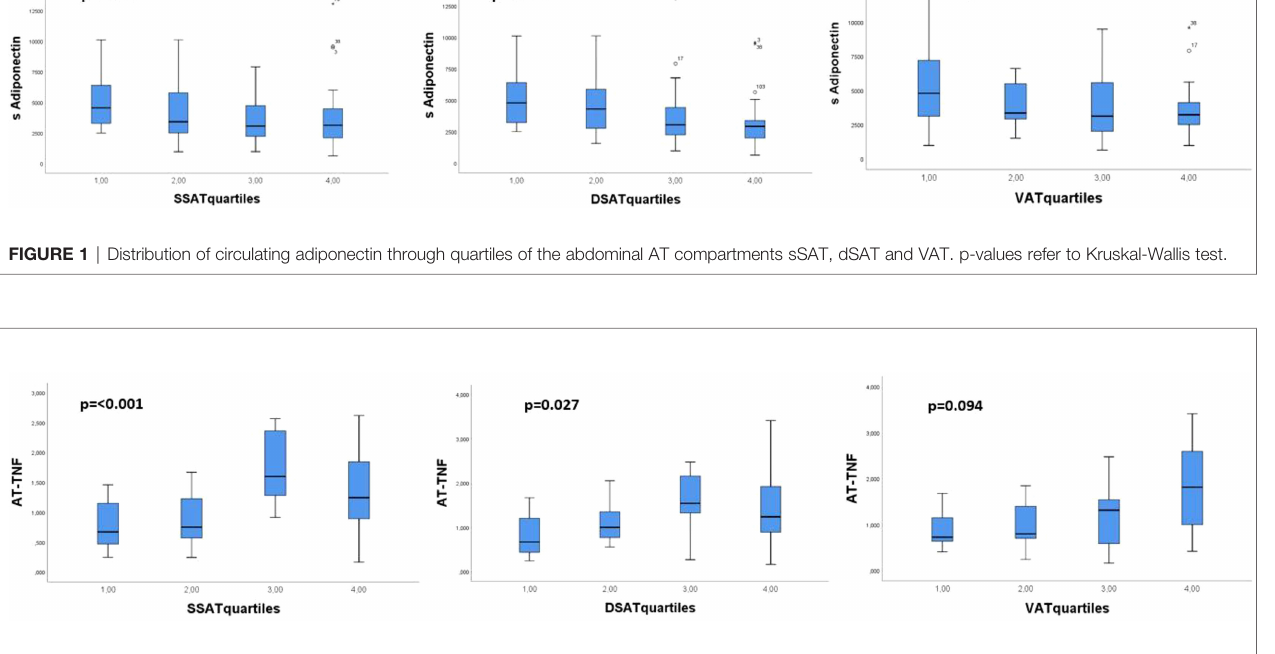
FIGURE 2 | Distribution of genetically expressed TNF a through the abdominal AT compartments sSAT, dSAT and VAT/ Kruskal-Wallis